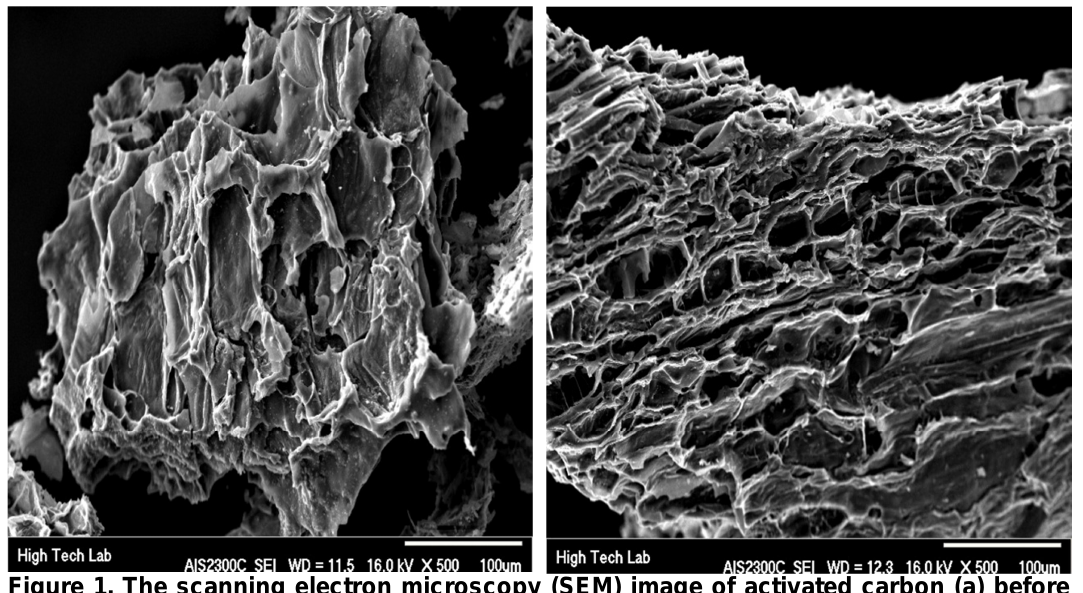
Figure 1. The scanning electron microscopy (SEM) image of activated carbon (a) before and (b) after the uptake